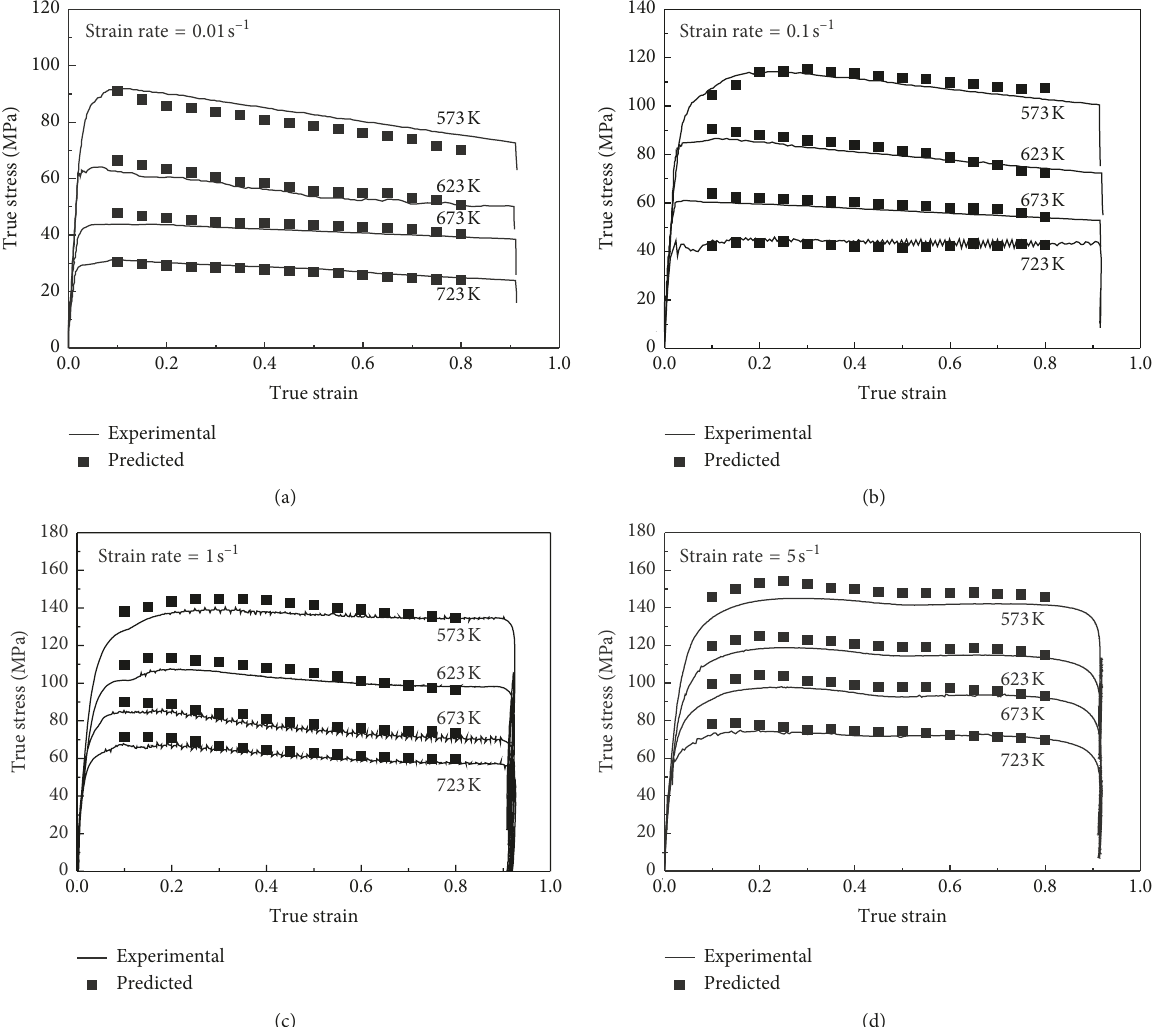
Figure 5: Comparisons of the experimental and the predicted flow stress from the constitutive models based on orthogonal analysis under PSC